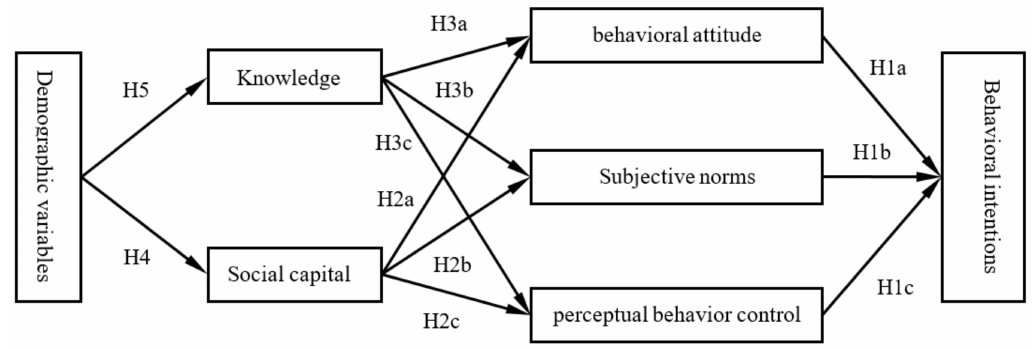
Figure 2. The three-level hypothesis model of the behavioral intentions (BI) of cervical cancer